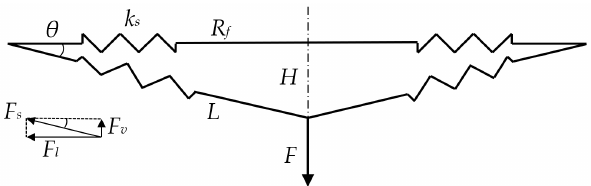
Figure 2. Sketch model of the trampoline under external force.